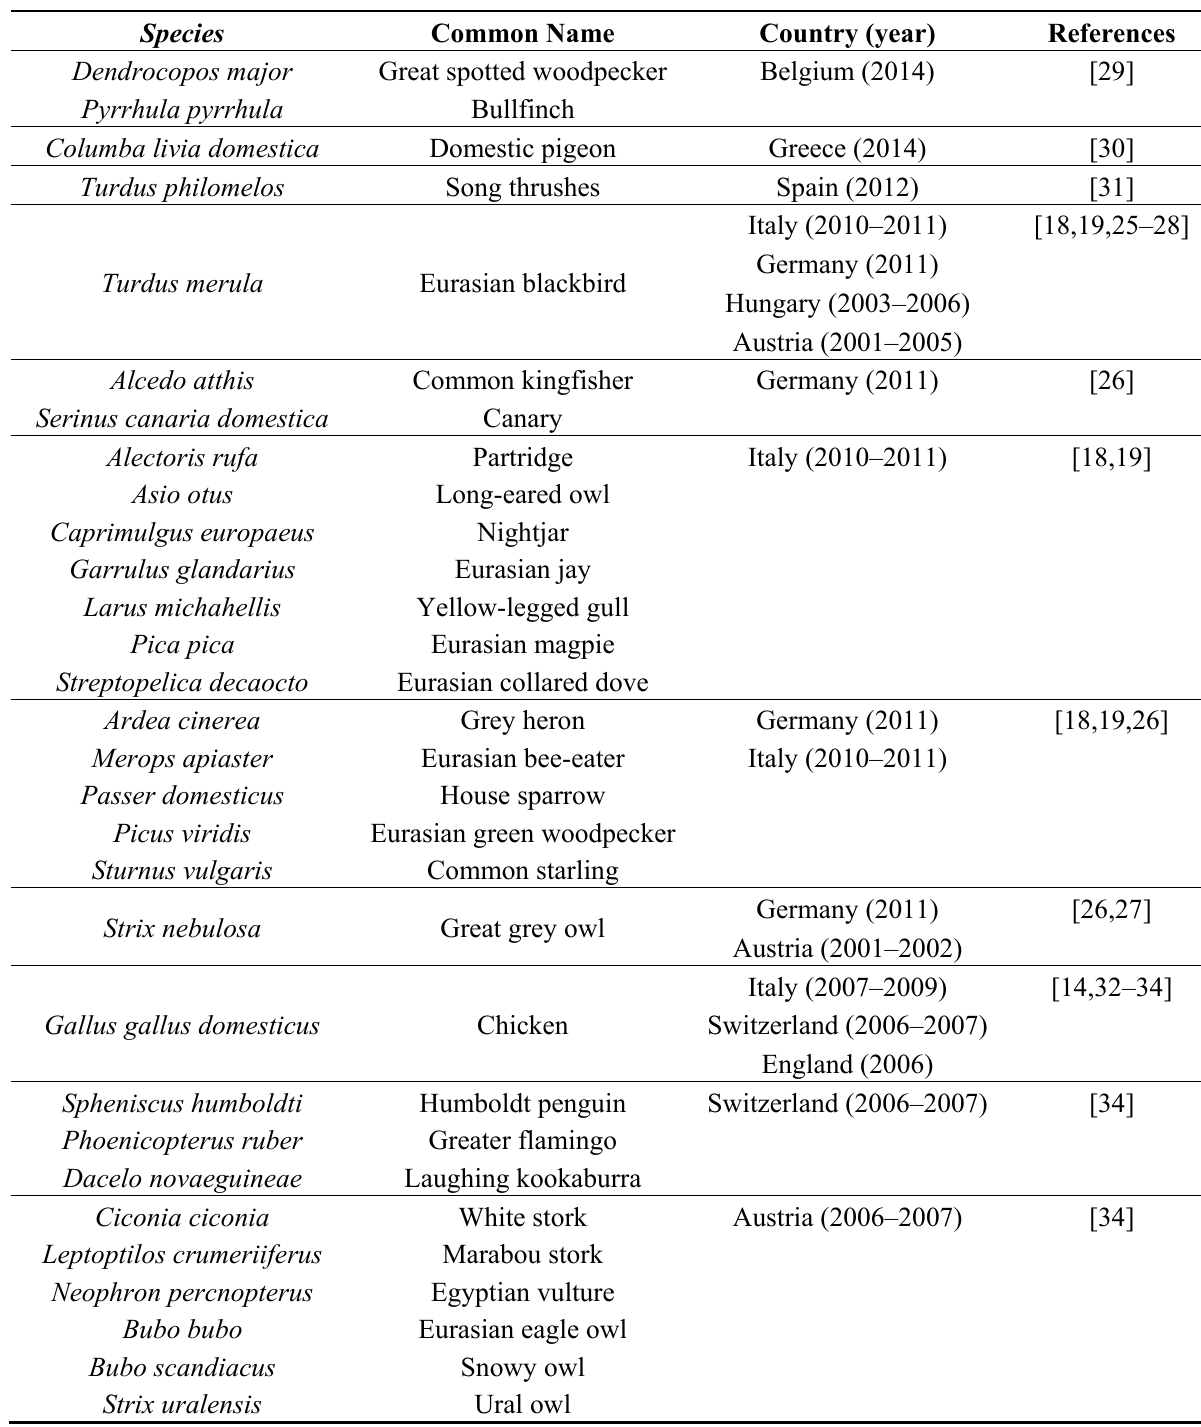
Table 1. Avian species infected with USUV in